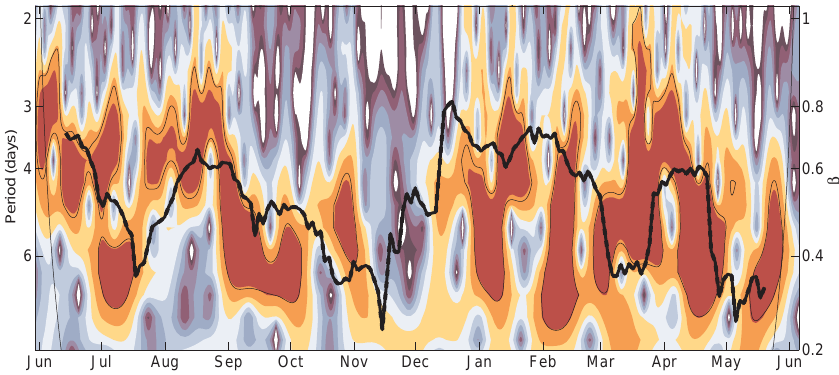
Figure 11. Time series of β v = EKE v / EKE (thick, black line) superimposed onto a wavelet diagram from S3 (same as shown in Fig. 3d). Red colours indicate high energy and the thin, black line is the 95% significance